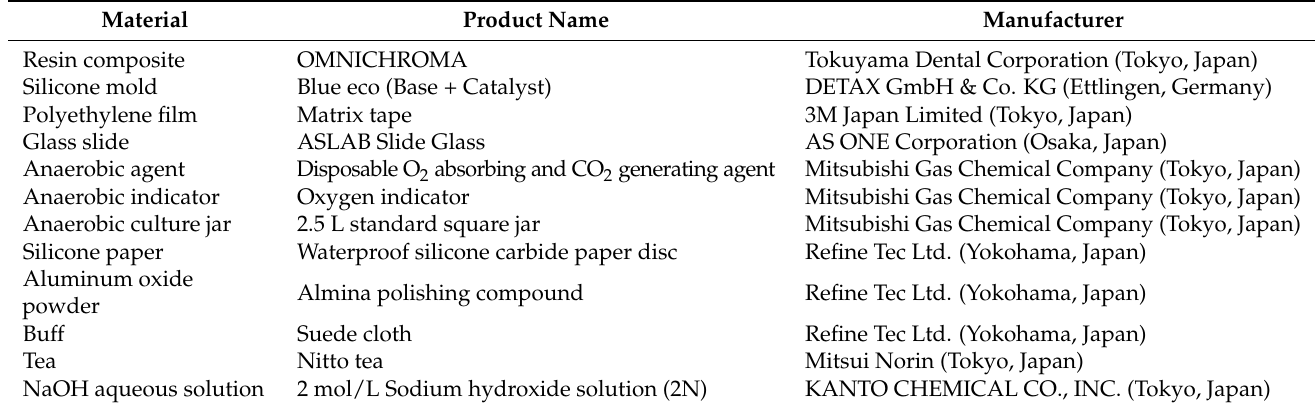
Table 1. Material used.